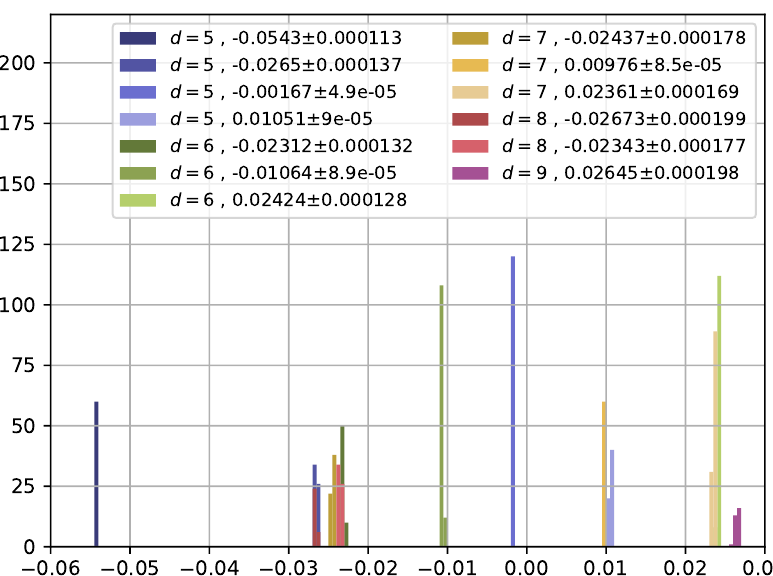
〉 in the ground state d bonds. The standard deviation 60